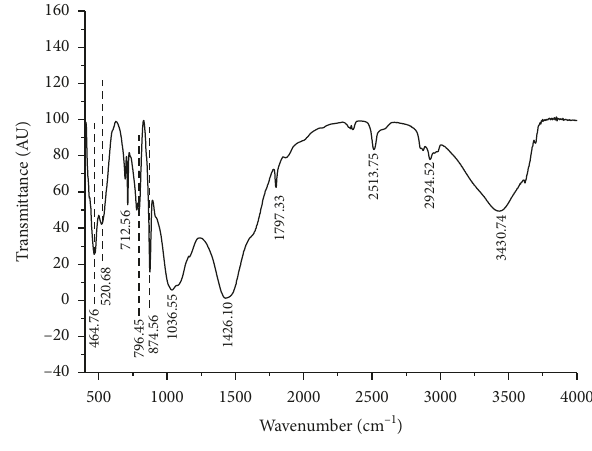
Figure 2: FTIR spectra of sediments.